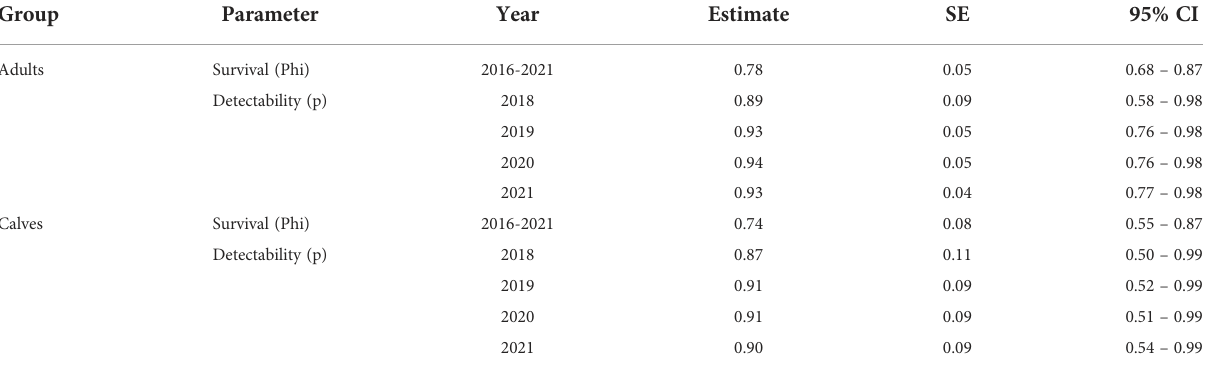
TABLE 4 Averaged parameter estimates for the four models within D AICc ≤ 2 from the best fi tting model in the CJS analysis for calves ’ survival. Group